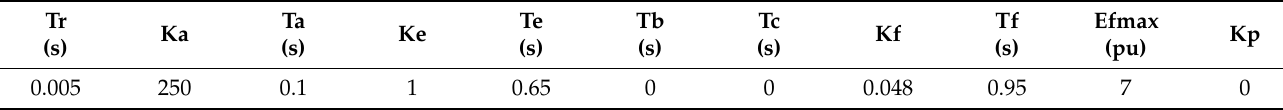
Table A6. Hydroelectric power plant parameters (excitation system).